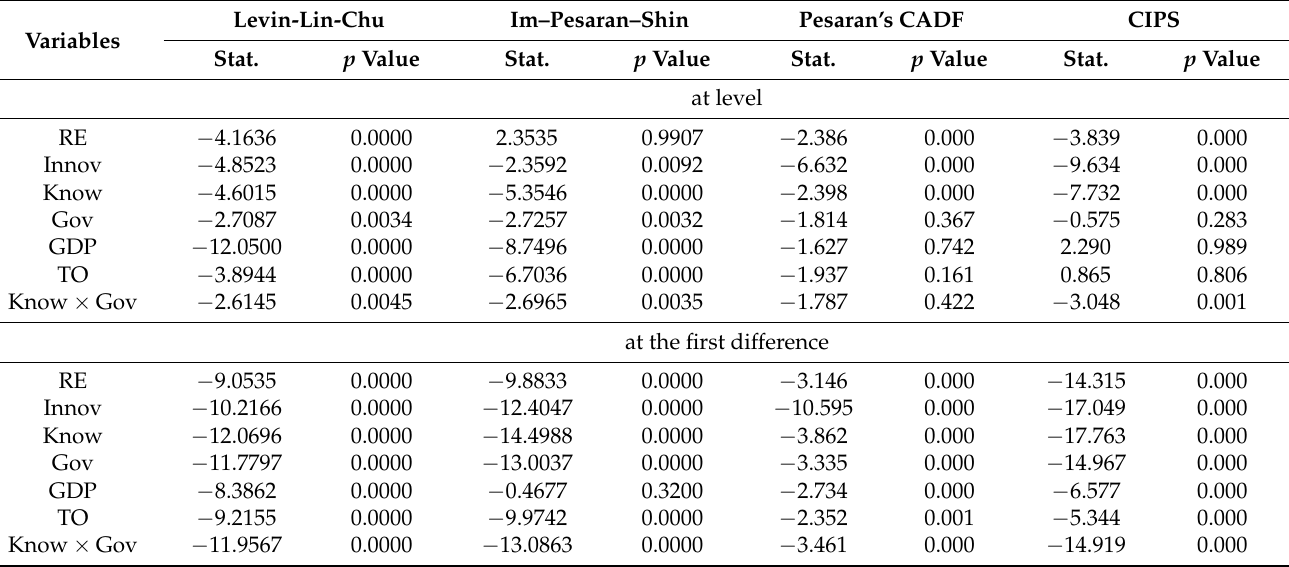
Table 2. The empirical results of stationarity testing in panels.